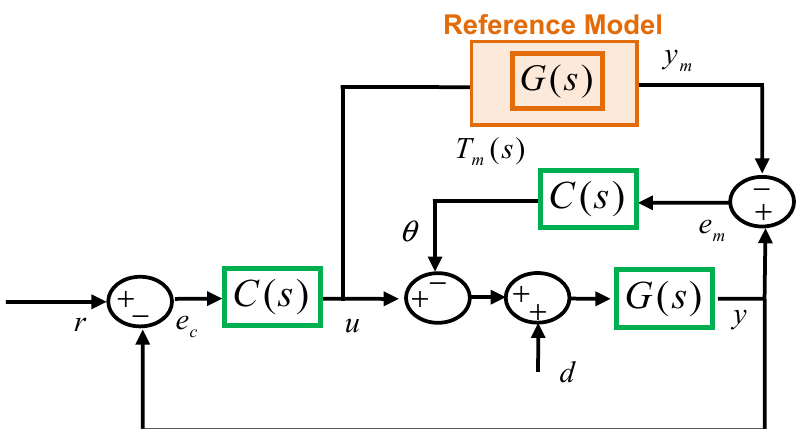
Figure 16. Block diagram of ML-MR PID-PID-PFA control structure.